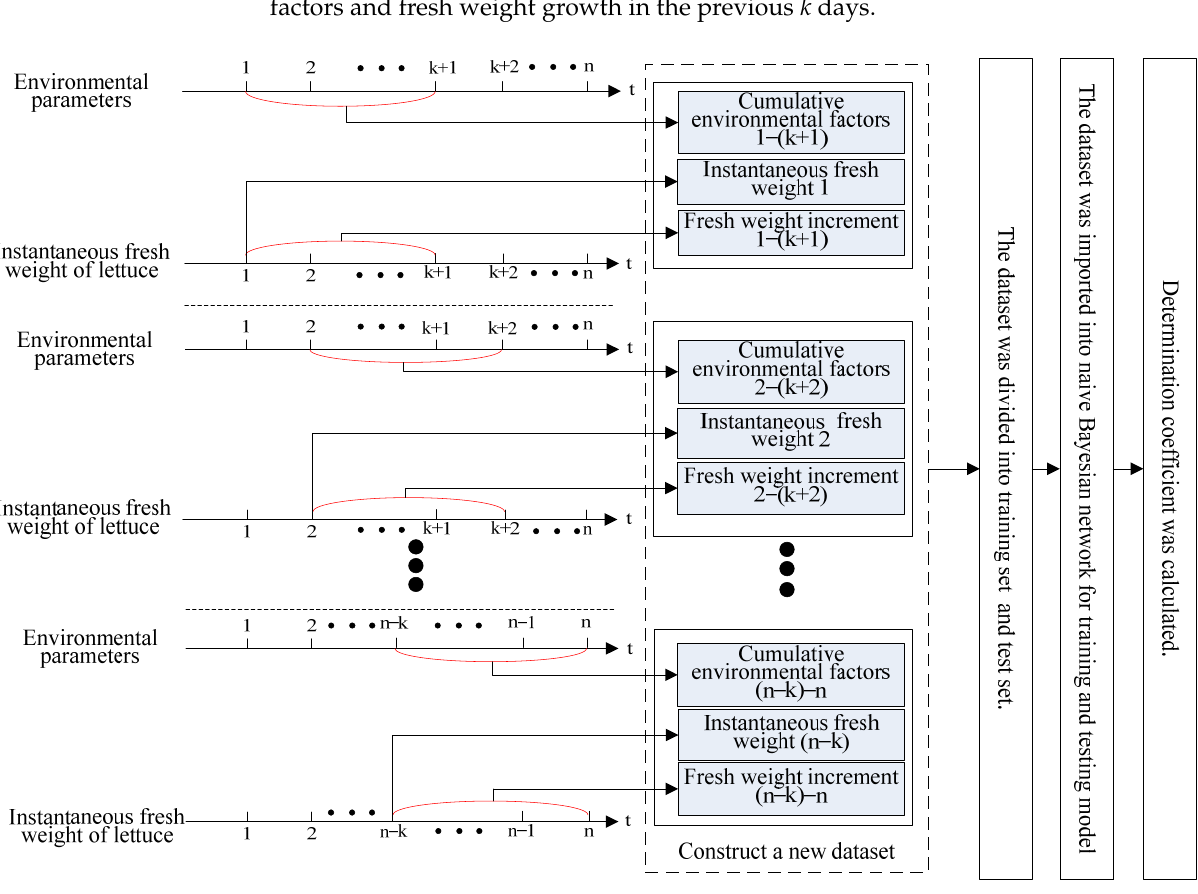
Figure 3. Schematic diagram of the solution process for the most significant response between cumulative environmental factors and fresh weight growth in the previous k days.